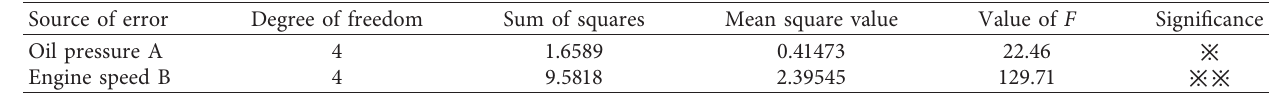
Table 4: ANOVA with all-factors test for dynamic